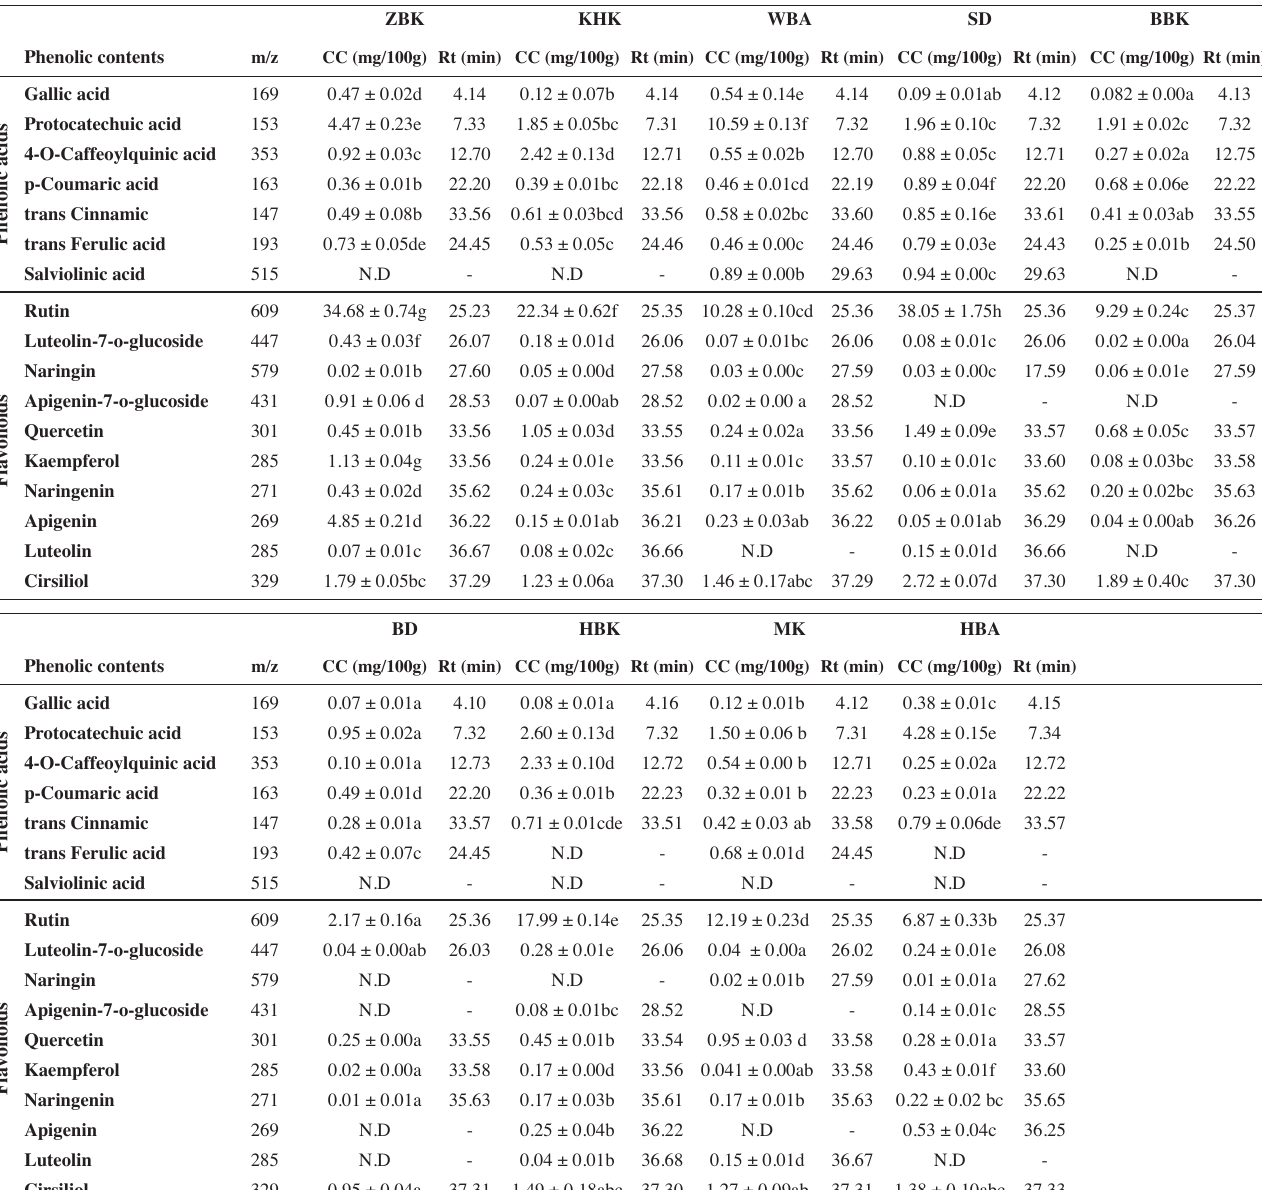
Tab. 3: Phenolic acid and flavonoid profiles in the nine Tunisian dry fig